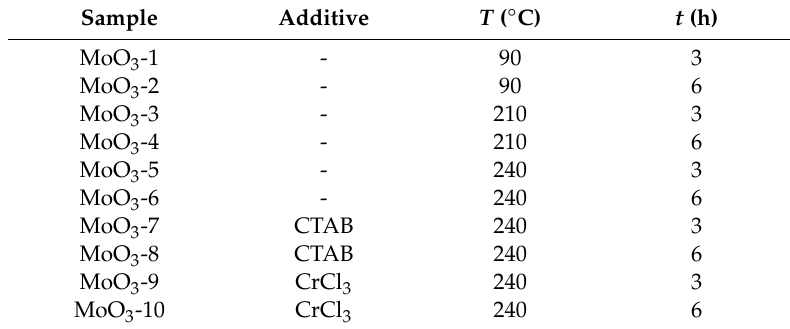
Table 1. Experimental conditions of the hydrothermal reaction between AHM and HNO 3 . Sample Additive T ( ◦ C) MoO 3